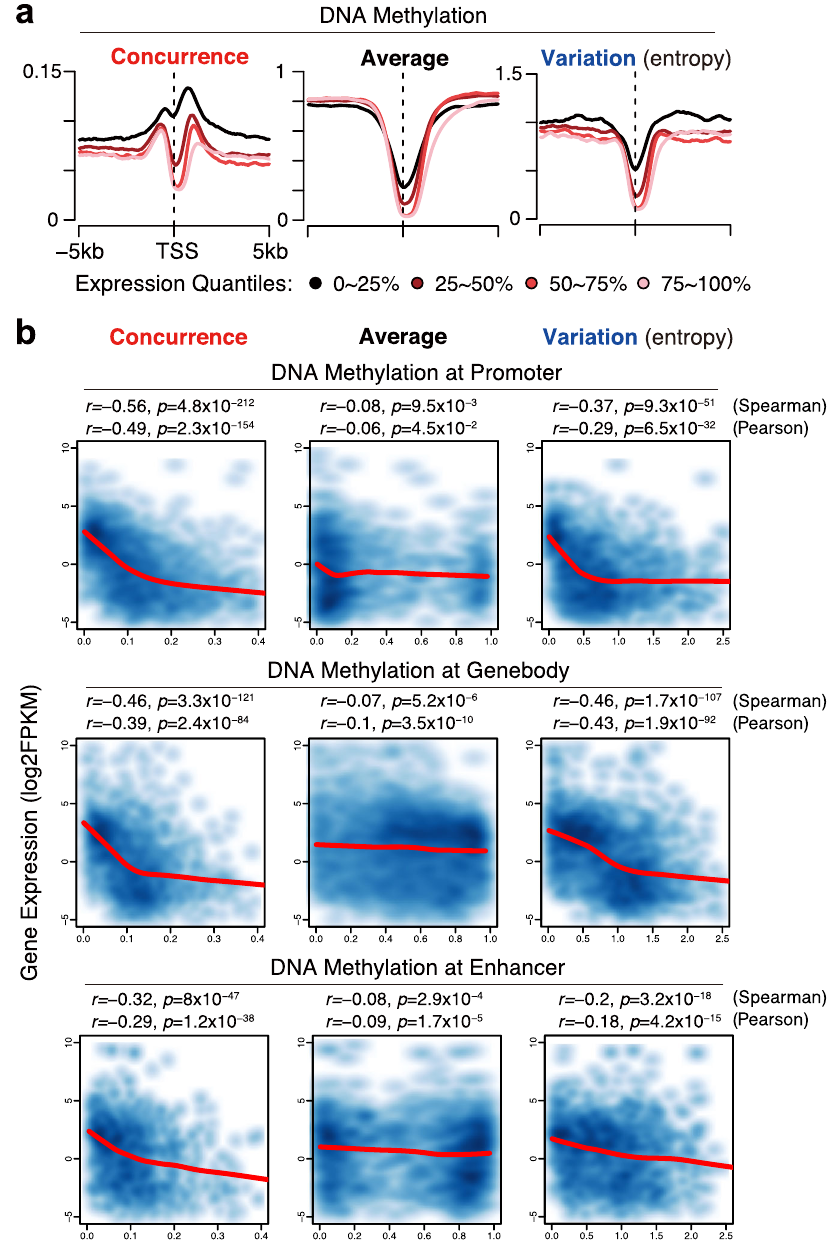
Fig. 2 Methylation concurrence is negatively associated with gene expression. a Average pro fi les in TSS-proximal regions of four gene groups, divided by quantiles of expression levels, in CD3 + T cells. Methylation-concurrence ratios are on the left, average methylation ratios are in the middle, and methylation variation scores(entropy) are shown on the right. 0 – 25%, lowest expressed; 25 – 50%, lower expressed; 50 – 75%, higher expressed; 75 – 100%, highest expressed. The gene number of each group is 3600. b The promoter/gene-body/enhancer methylation concurrence ratios (1st column) are strongly negatively correlated with gene expression level in CD3 + T cells, and this correlation is stronger than that of the average methylation (2nd column) and the methylation variation (3rd column). Promoter regions are from 1 kb upstream to 500 bp downstream of TSS. Gene-body regions are from 500 bp downstream of TSS to TTS. Enhancer regions are de fi ned based on chromatin interactions validated by Hi-C data (see Methods). The WGBS data are from the Roadmap project with GEO accession number GSM1186660. The CD3 + primary cells are from a 37-year-old male. To increase reliability, we select regulatory elements whose CpGs are all suf fi ciently covered ( ≥ 4 reads). To make fair comparisons, only the elements which can be detected by all three metrics are included. This results in 9876 promoter regions, 14,868 gene-body regions, and 3351 enhancer regions. Spearman ’ s rank correlation and Pearson ’ s correlation were calculated based on all data points. P values were calculated by the two-tailed correlation test. LOWESS lines were plotted to describe the relationships between variables (indicated by red methylation, methylation concurrence, and methylation varia- genes (P1), 842 methylation-concurrence stable and average tion. Through an overlap analysis between methylation concur- methylation increased (hypermethylated) genes (P2), and 265 rence and average methylation, we identify three gene groups: 487 methylation-concurrence elevated and average methylation methylation-concurrence elevated and average-methylation stable increased (hypermethylated) genes (P3) (Fig. 3a). For the three